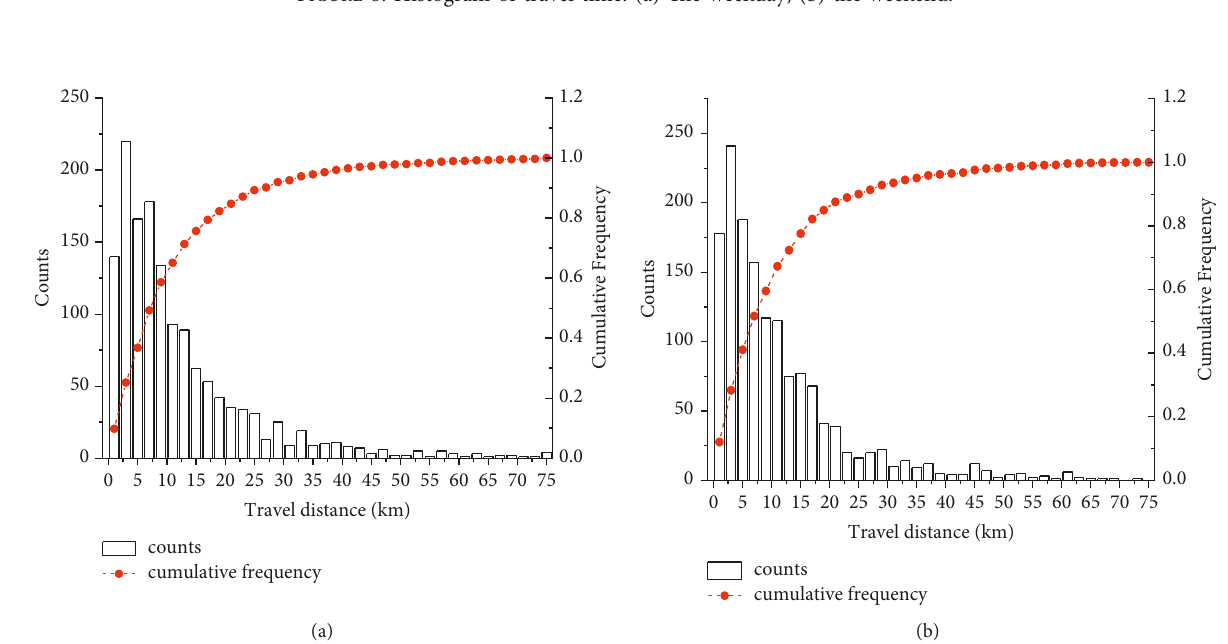
Figure 9: Histogram of travel distance. (a) The weekday; (b) the weekend.